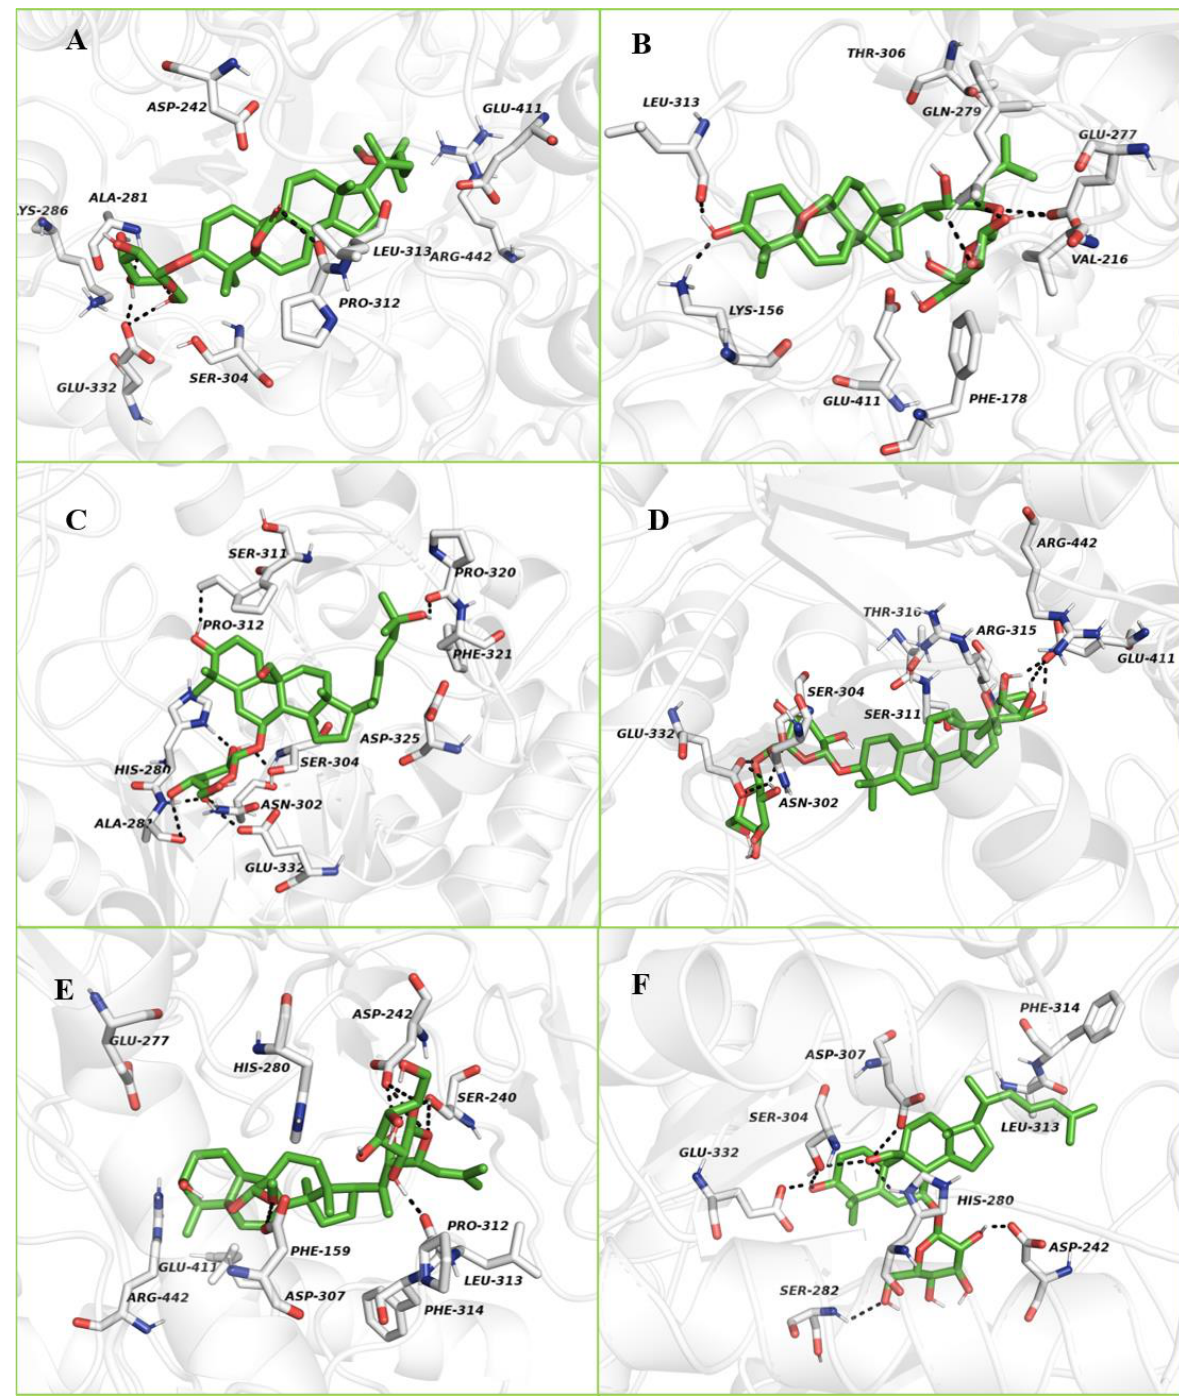
Figure 6. The 3D protein-ligand interactions for ( A ) karaviloside VI ( 2 ), ( B ) karaviloside VIII ( 3 ), ( C ) momordicoside L ( 4 ), ( D ) momordicoside A ( 5 ), ( E ) charantoside XV ( 6 ), and ( F ) kuguaglycoside C ( 7 ) in the binding sites of isomaltase. Black dotted lines indicate hydrogen bonds between compounds and amino acid residues. Ligands in the active sites are denoted in green color. Active site residues are shown in white